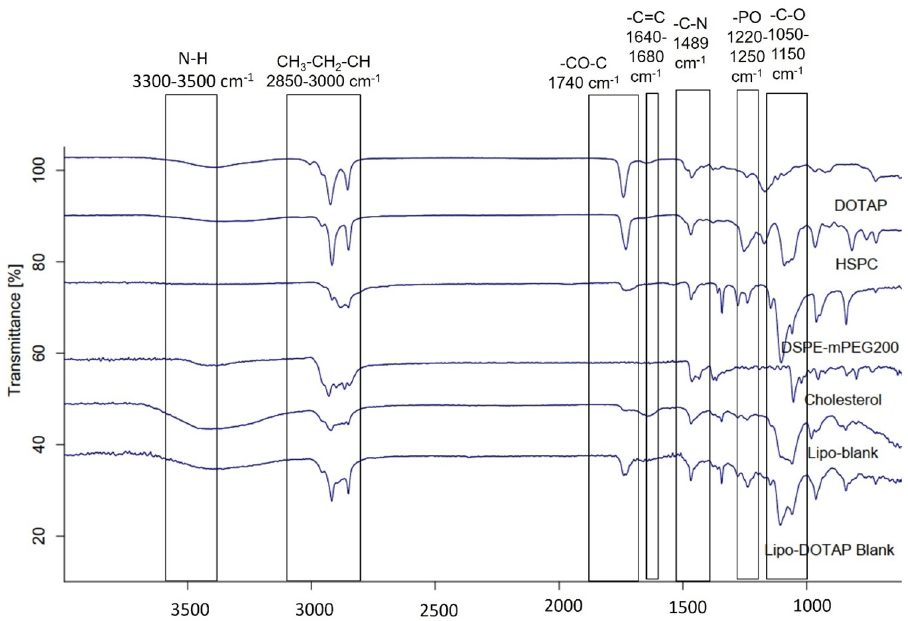
Figure 3. FTIR spectra of β-ionone, DOTAP, HSPC, DSPE-mPEG2000, cholesterol, Lipo-Blank, and Lipo- DOTAP Blank. Lipo-Blank contained no DOTAP or β-ionone, while Lipo-DOTAP Blank contained DOTAP at the highest concentration without the addition of